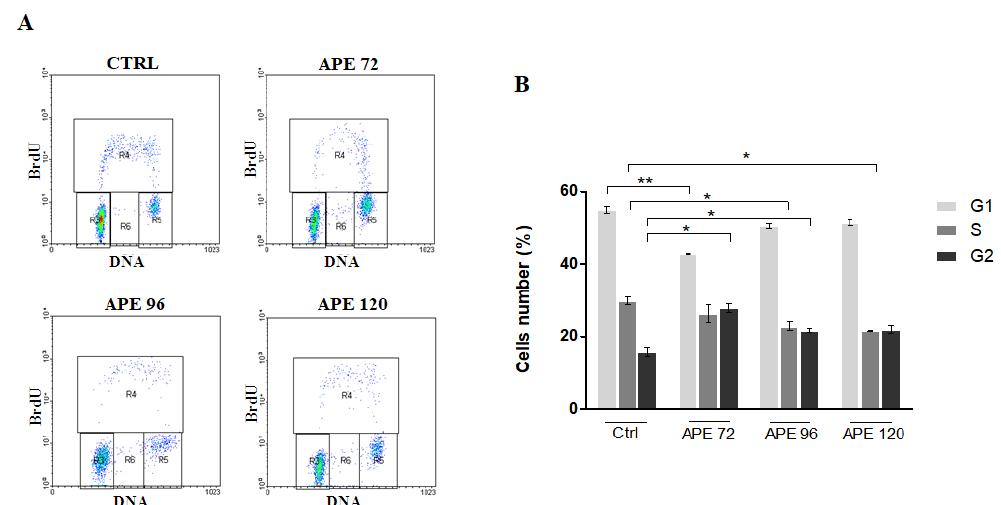
Figure 4. ( A ) Bivariate analysis of BrdU incorporation and DNA content in GB8 cells at 72, 96 and 120 h after 100 μM APE treatment. ( B ) Percentage of GB8 cells in G1, S, G2/M phases after 100 μM APE treatment. (t-test; * p < 0.05; ** p < 0.01). The data are the average ± SEM of three independent experiments.